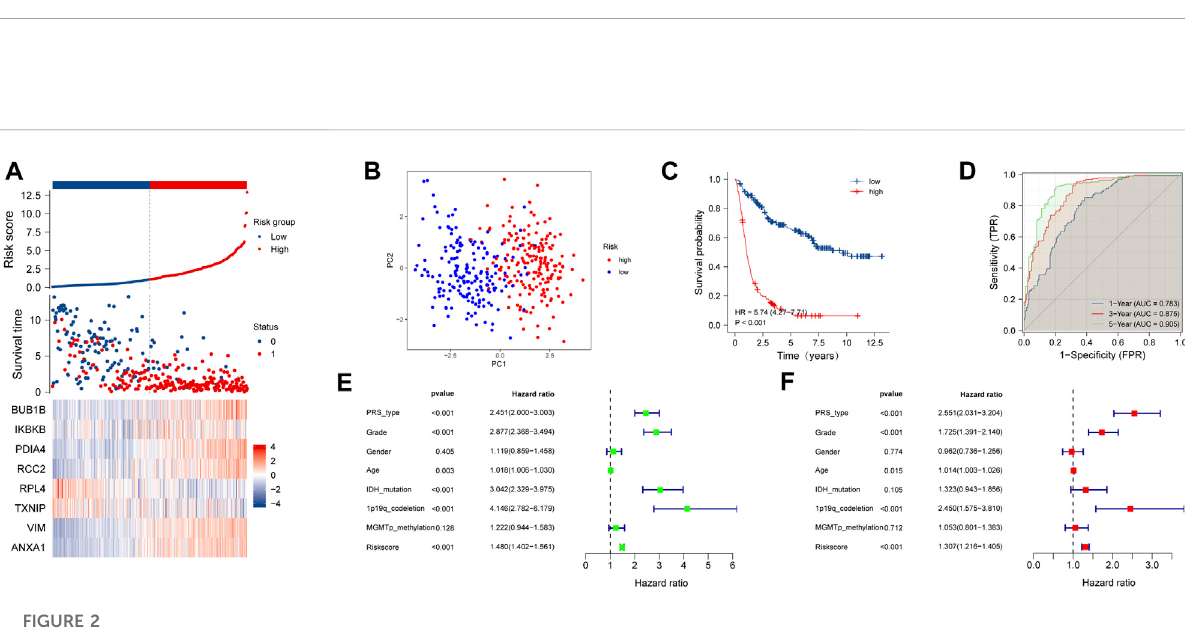
FIGURE 1 Identi fi cation of NRDEGs and construction of NRDEG prognostic signature in glioma. (A) Venn diagrams of NRGs and DEGs in four cohorts. (B) Heatmap of NRDEGs in the four cohorts (GSE4290, GSE16011, Rembrandt, and TCGA + GTEx). (C) PPI network of NRDEGs. (D) LASSO regression model. (E) Identi fi cation of collinearity genes and removal. (F) Multivariate Cox regression analysis of the eight NRDEGs in the CGGA database.